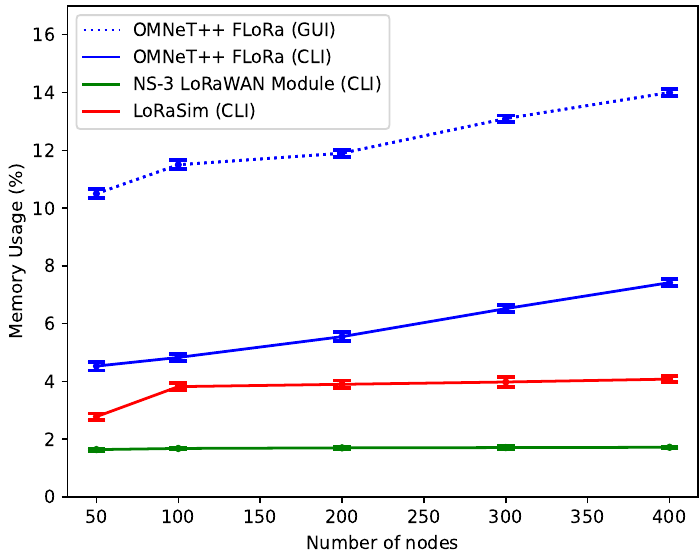
Figure 11. Memory usage vs. number of nodes.